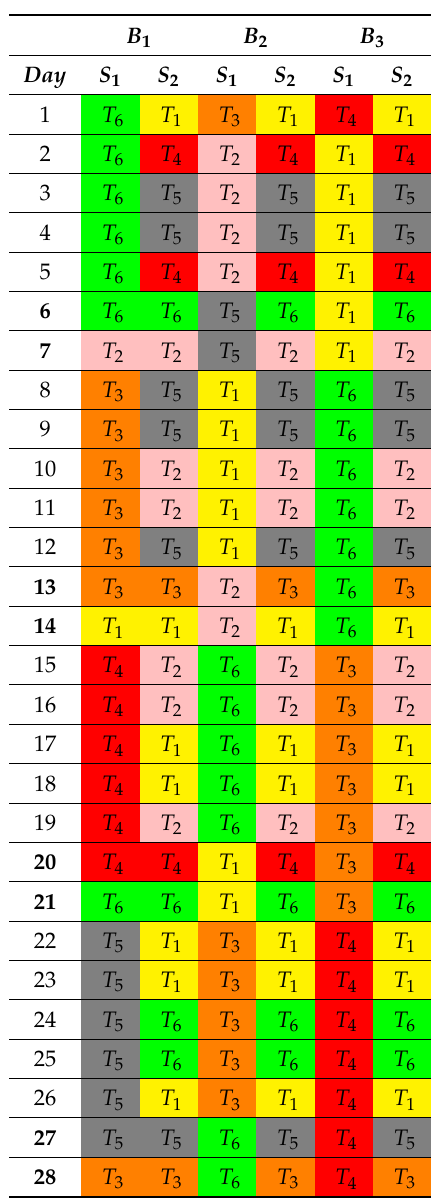
Table 1. Manual physician schedule for